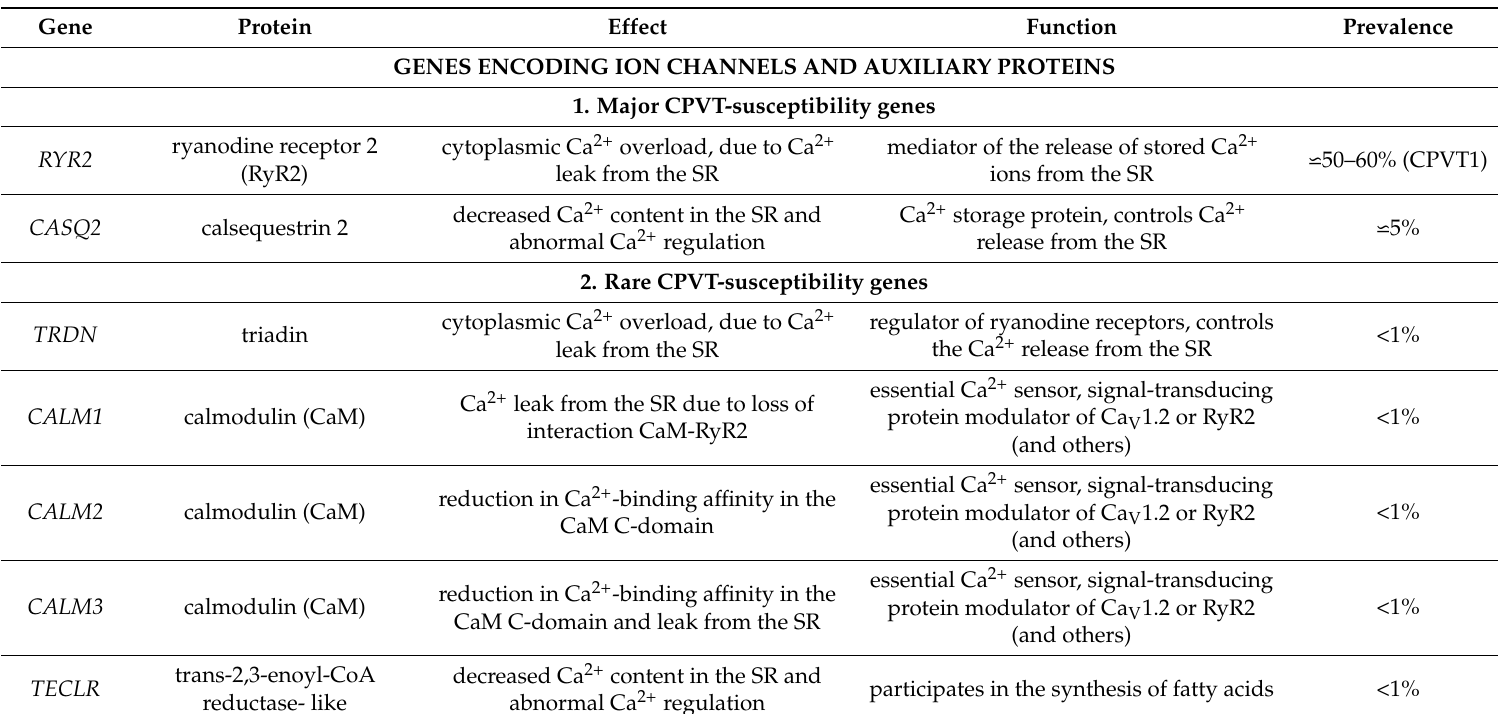
Table 4. Mutations associated with the